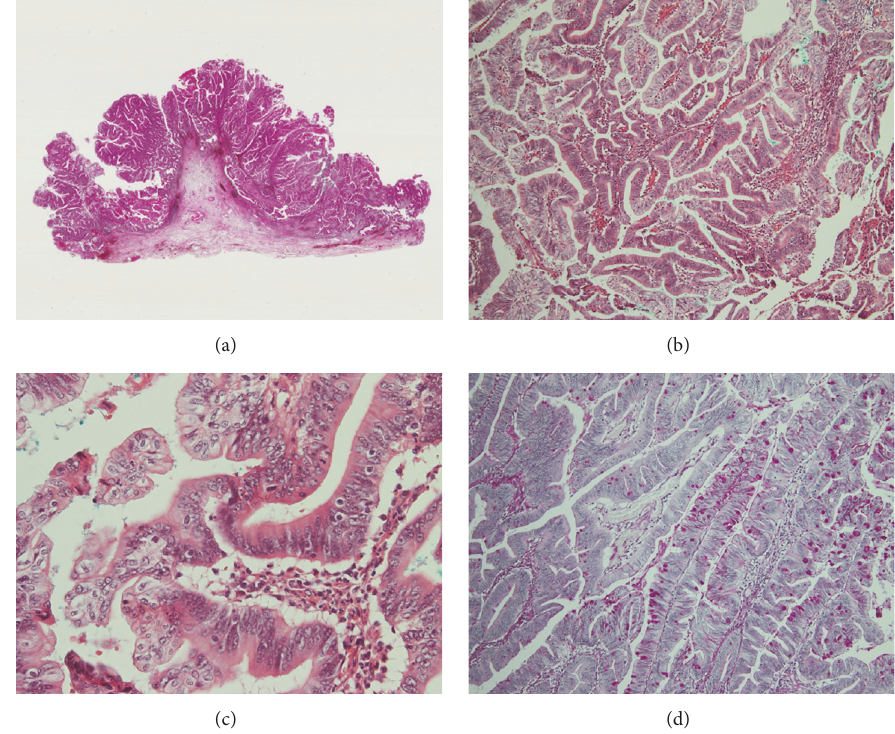
Figure 2: (a) Low-power view of the tumor shows papillomatous nodule. No tumor invasion was seen. HE staining. (b) Villous adenomatous tumor is observed. HE staining. (c) Tumor cells show high-grade nuclear atypia. (d) PAS staining shows positive staining for the goblet cells.